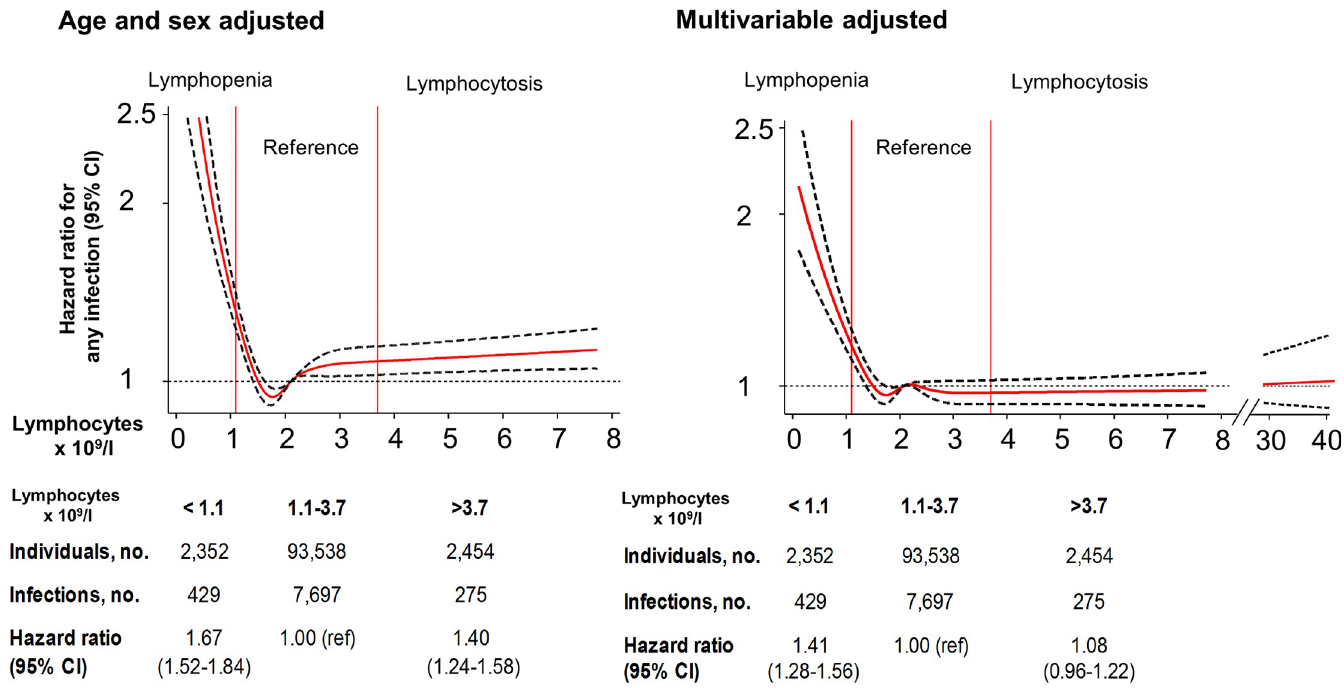
Fig 3. Risk of any infection as a function of lymphocyte count for individuals from the Copenhagen General Population Study. Solid red lines are hazard ratios, and dashed black lines indicate 95% confidence intervals based on fitting of cubic splines to risk estimates obtained using Cox proportional hazards regression. Multivariable adjustment includes all covariates listed in Table 1 except age, but with age as the underlying timescale. The median lymphocyte value of 2.1 × 10 9 /l was set as reference for the continuous model. For the multivariable adjusted model, the lymphocyte interval 30–40 × 10 9 /l is added to illustrate that for very high lymphocyte counts the risk of infections increases, but with a broad confidence interval. When categorizing lymphocyte counts, lymphopenia was defined as a lymphocyte count below the 2.5th percentile, the reference category was defined as a lymphocyte count between the 2.5th and 97.5th percentile, and lymphocytosis was defined as a lymphocyte count above the 97.5th